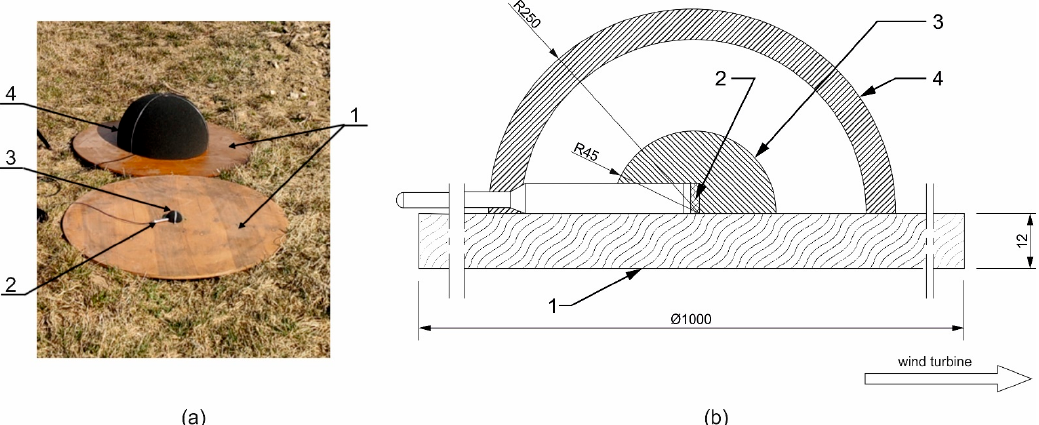
Figure 1. ZTW-1 kit for measuring wind turbine noise manufactured by SONOPAN Sp. z o.o. conforming to [32]: ( a ) overview, ( b ) cross-section. (1)—wooden measuring board, (2)—microphone, foam windshield: (3)—inner and (4)—outer [33].